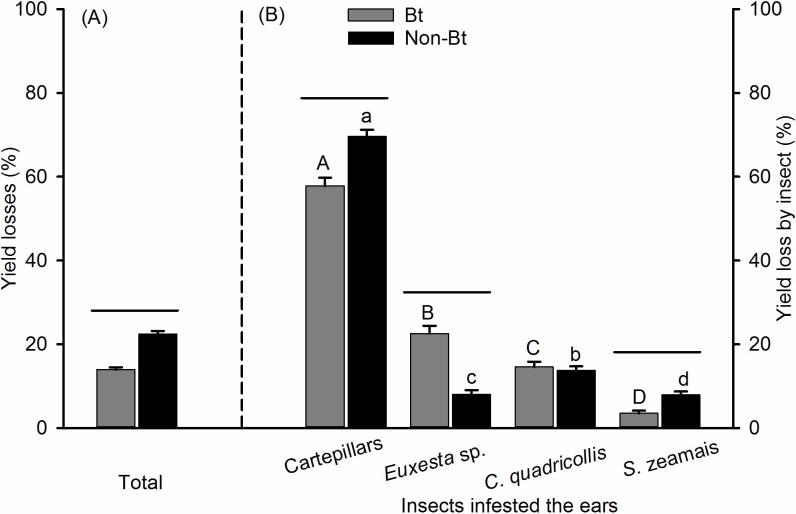
Mean losses (± SE) caused by insects in Bt and non-Bt corn in the second season of cultivation.(A) Total yield losses caused by insects, (B) yield losses caused by each insect within the total yield losses by insects. Means followed by the same letter are similar according to Dunn's test (P < 0.05); a capital letter represents grain losses of Bt corn; and a lowercase letter represents grain losses of non-Bt corn. A line represents a significant difference between Bt and non-Bt corn means according to Mann-Whitney U-test for the two groups (P < 0.05).